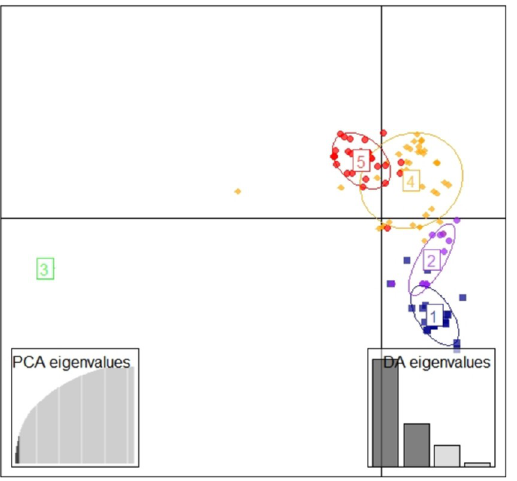
Fig 6. Population structure according to the DAPC using 18,124 SNPs. The first two components are displayed graphically (each sub-population is differentiated by color). https://doi.org/10.1371/journal.pone.0256002.g006 populations, the first two axes explained 17.2% of the total variation, corresponding to 9.8 and 7.4% for the first and second axis, respectively (Fig 8). Results showed pair wise fixation index of 0.071, 0.095, 0.073 and 0.083 between elite genotypes and local landraces of Imbo plain, Mumirwa slopes, North east depressions and Central plateau, respectively, that showed little variation (Table 4). Between local landraces of Imbo plain and Mumirwa slopes, North East (NE) Depressions and Central plateau, the pair wise fixation index was 0.010, 0.023 and 0.020, respectively, indicating very low differentiation between populations. Pair wise fixation index between landraces of Mumirwa Slopes and NE Depressions, between landraces of Central pla- teau and NE Depressions were 0.027 and 0.028 respectively (Table 4). Within population, output values for pair wise fixation index were greater than 25% for all populations indicating high differentiation between genotypes (Table 5). Pair wise fixation index of 0.59, 0.60, 0.57, 0.59 and 0.56 was noted within elite genotypes and landraces of Imbo plain, Mumirwa slopes, NE depressions and Central plateau, respectively, indicating high vari- ation between genotypes (Table 5). The heterozygosity was calculated per marker and popula- tion (S8 Table), where observed heterozygosity (Ho) was greater than expected heterozygosity (He) in all populations except elite genotypes, indicating a suspected mixing of previously iso- lated populations (Table 5).